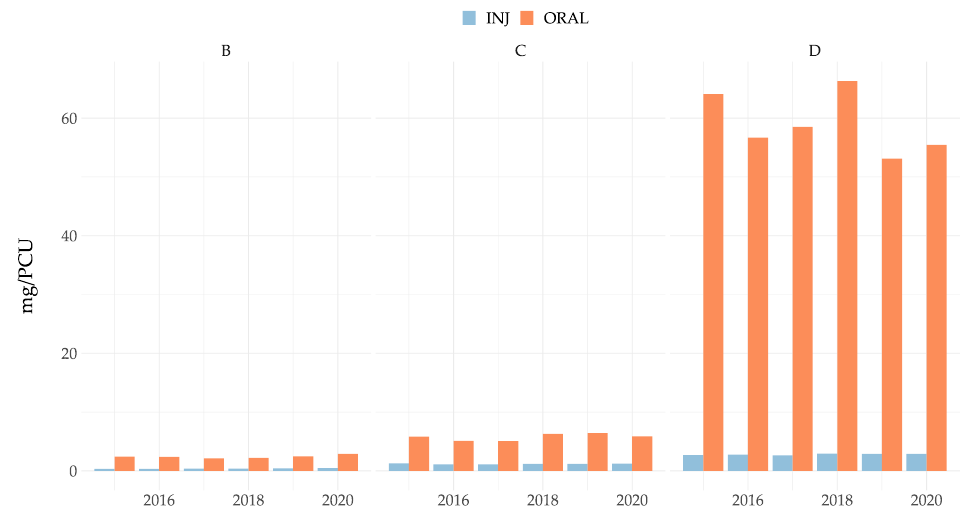
Figure 5. Antimicrobials (in mg/PCU) dispensed and divided by route of administration over time. INJ = systemic/injectable administration; ORAL = oral